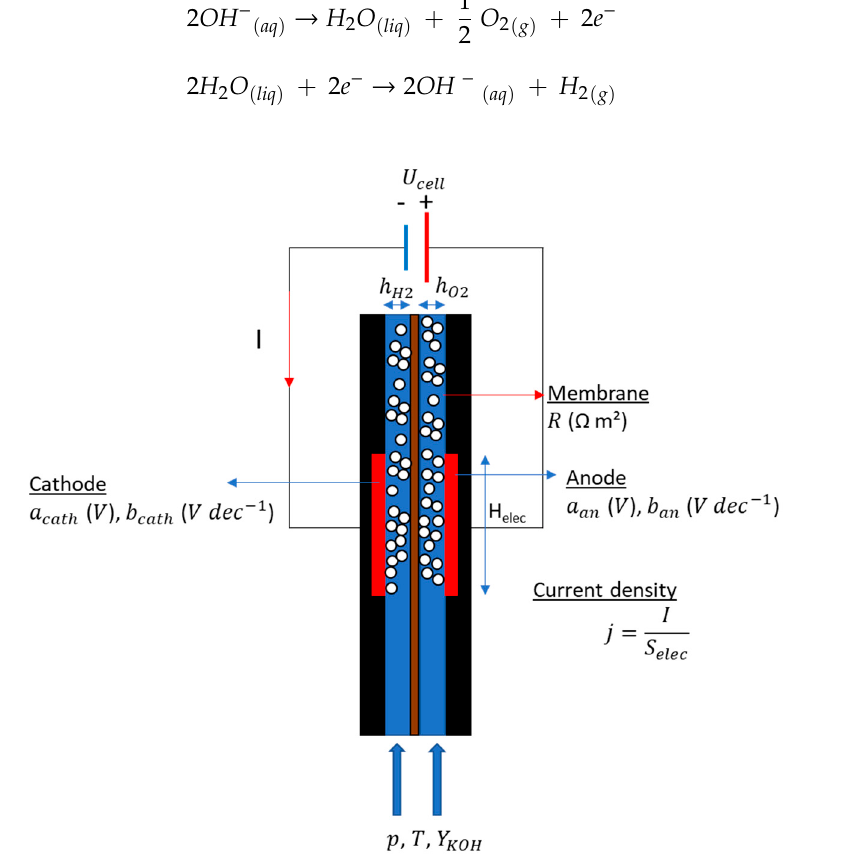
Figure 1. Design of the electrochemical cell.